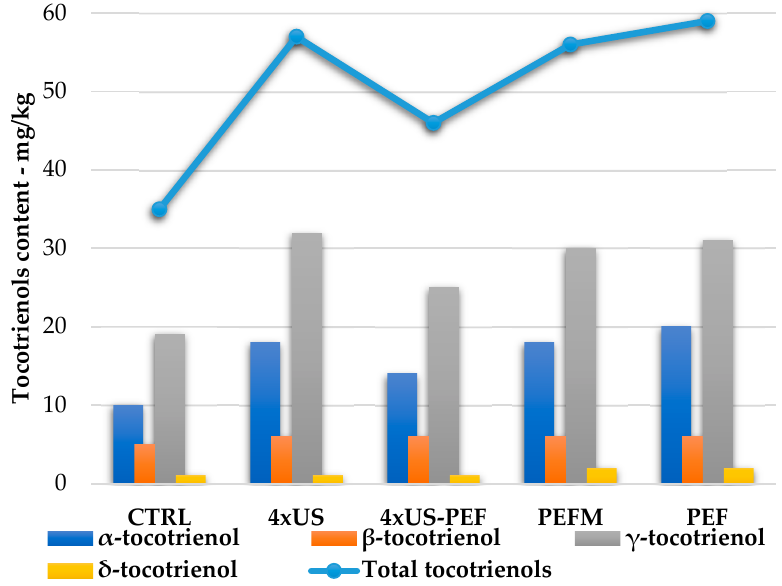
Figure 7. Tocotrienol contents in oil samples obtained from half-ripe Coratina olives according to processing technology (mg/kg).